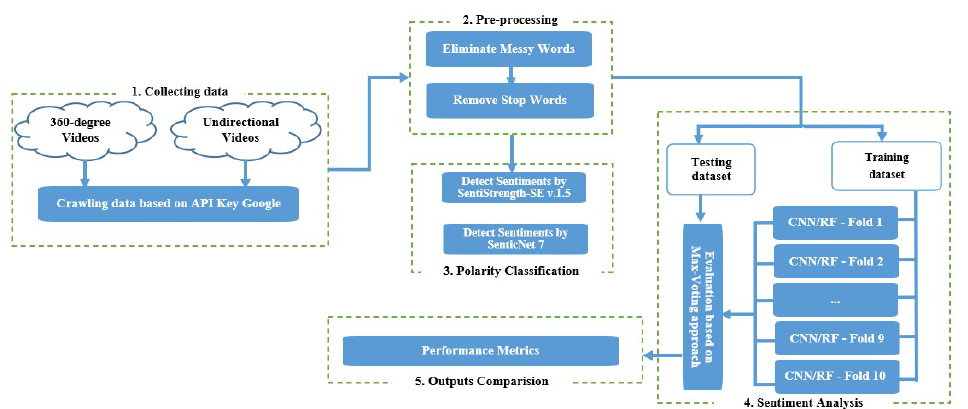
Figure 3. The flow diagram of opinion mining of YouTube comments.